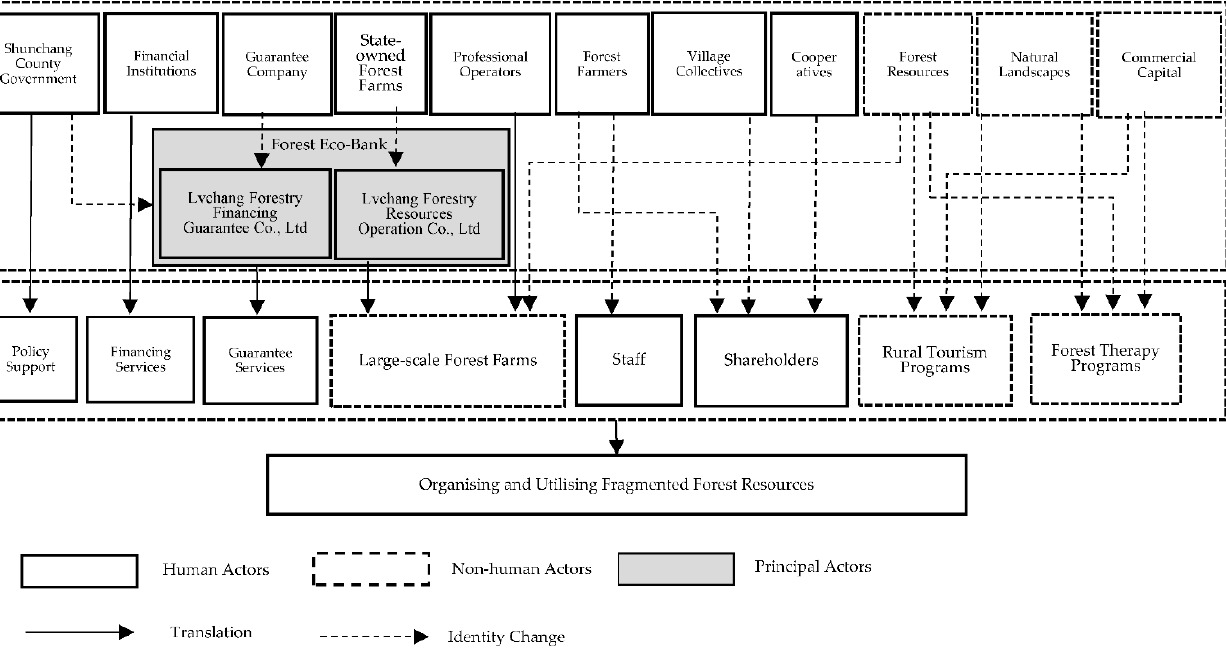
Figure 4. The FEB actors’ network and their mechanisms.